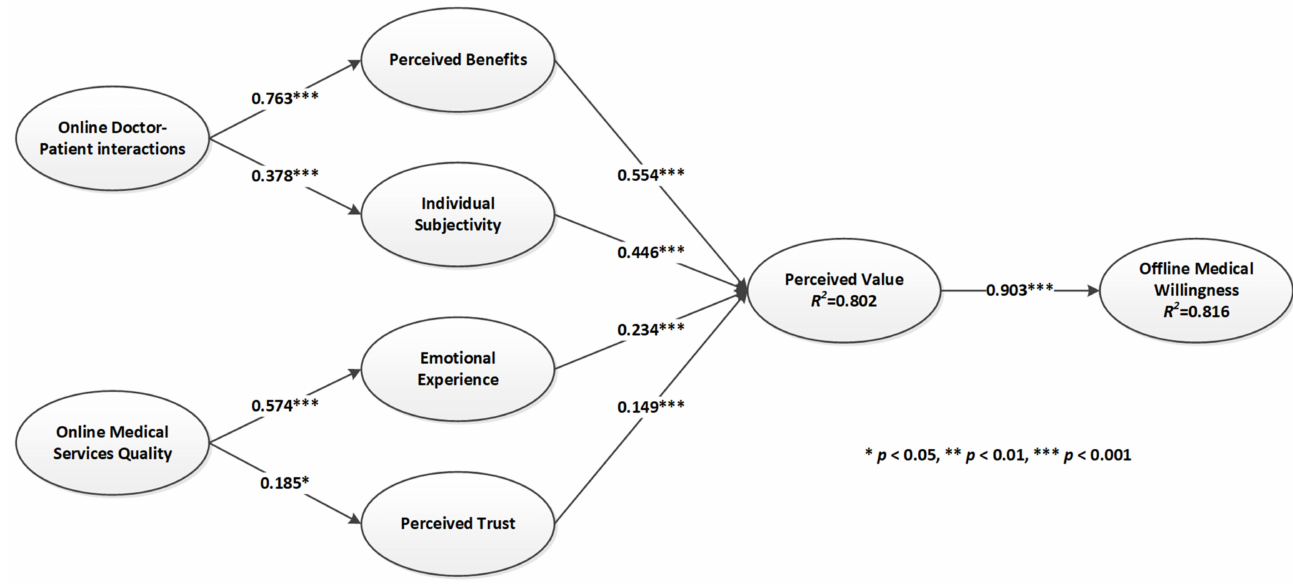
Figure 3. The path coefficient of research